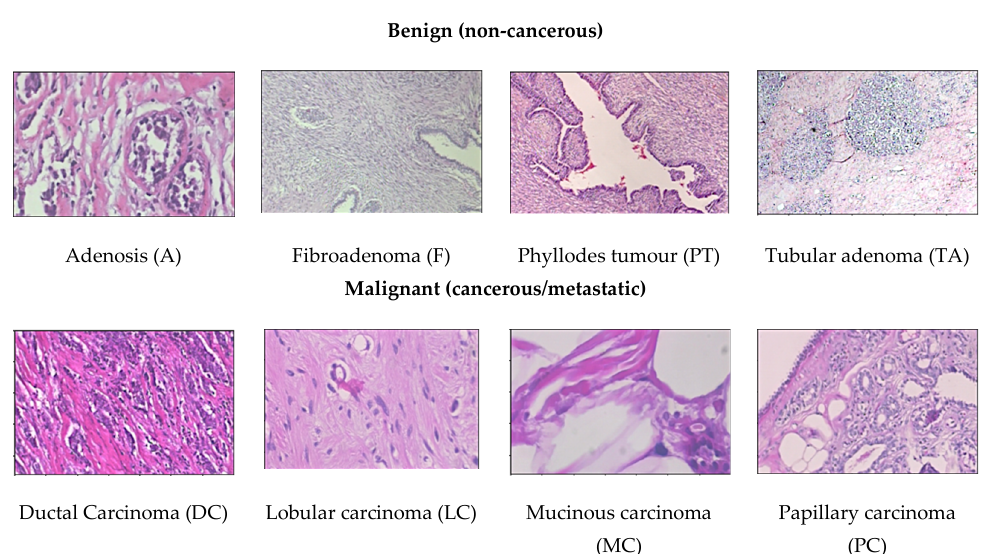
Figure 5. Sample of distinct types of breast cancer histopathology images from the BreaKHis dataset [15].